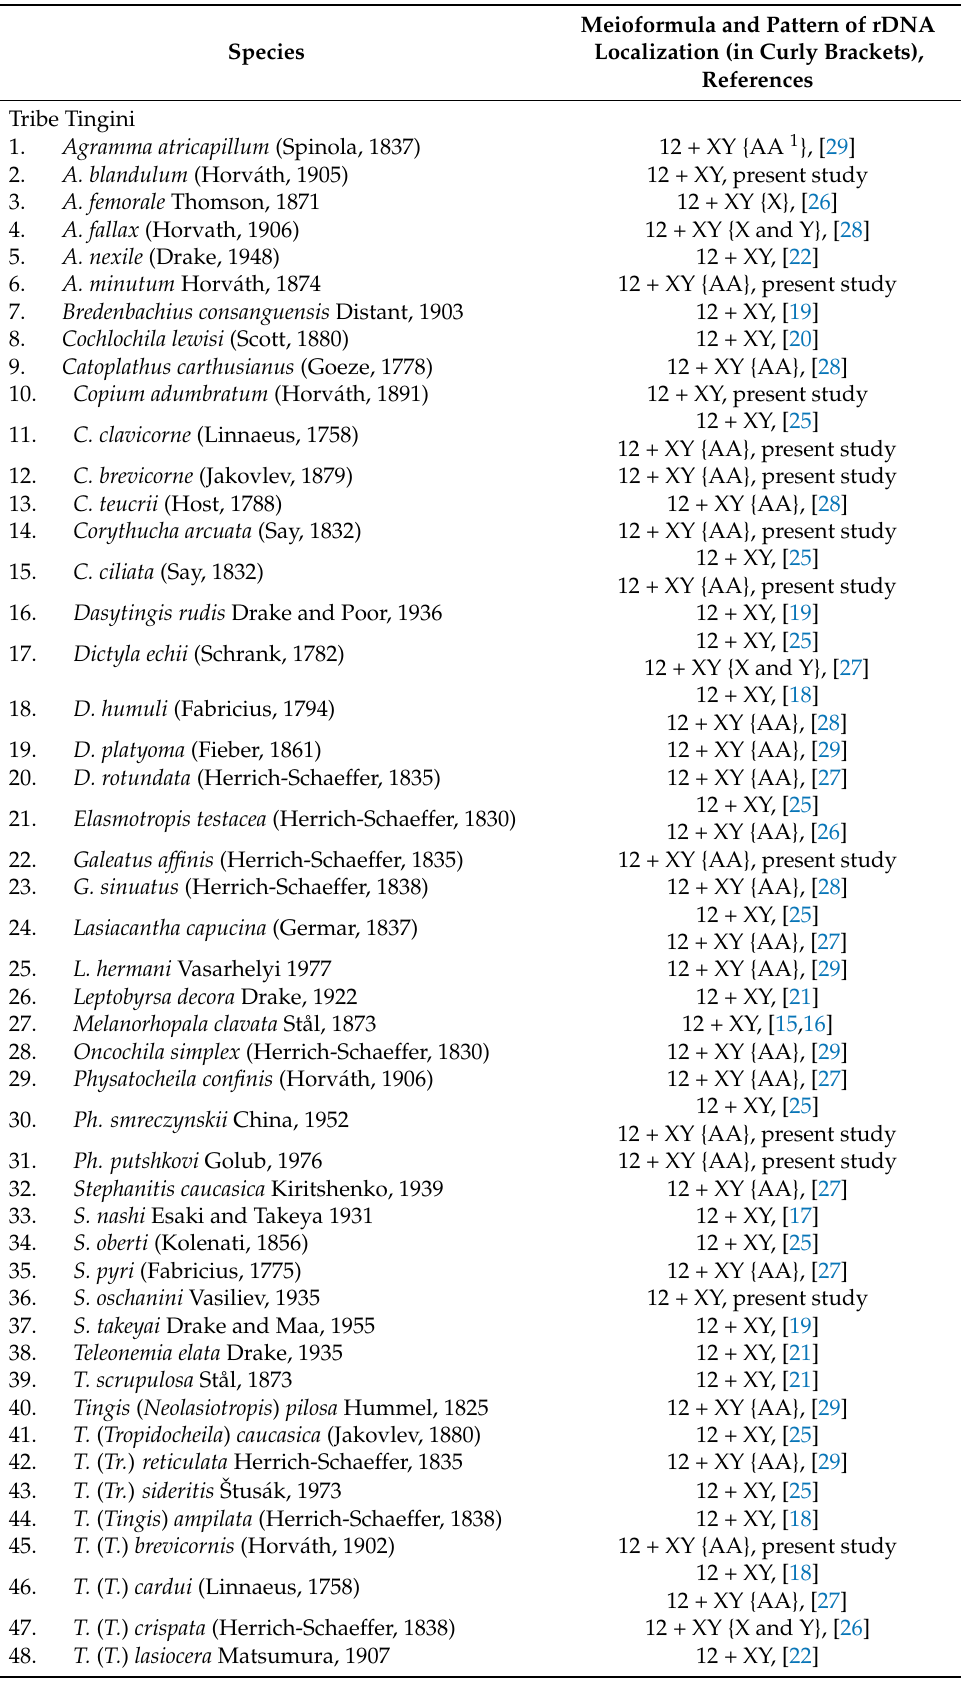
Table 2. Cytogenetically studied species of Tingidae. Species